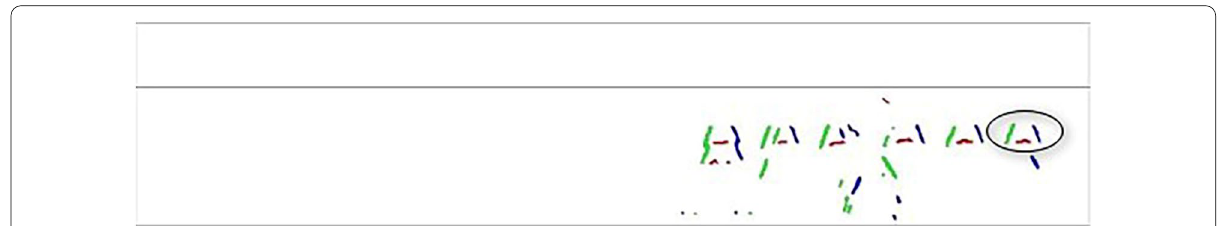
Figure 11 Ultrasound image in rail